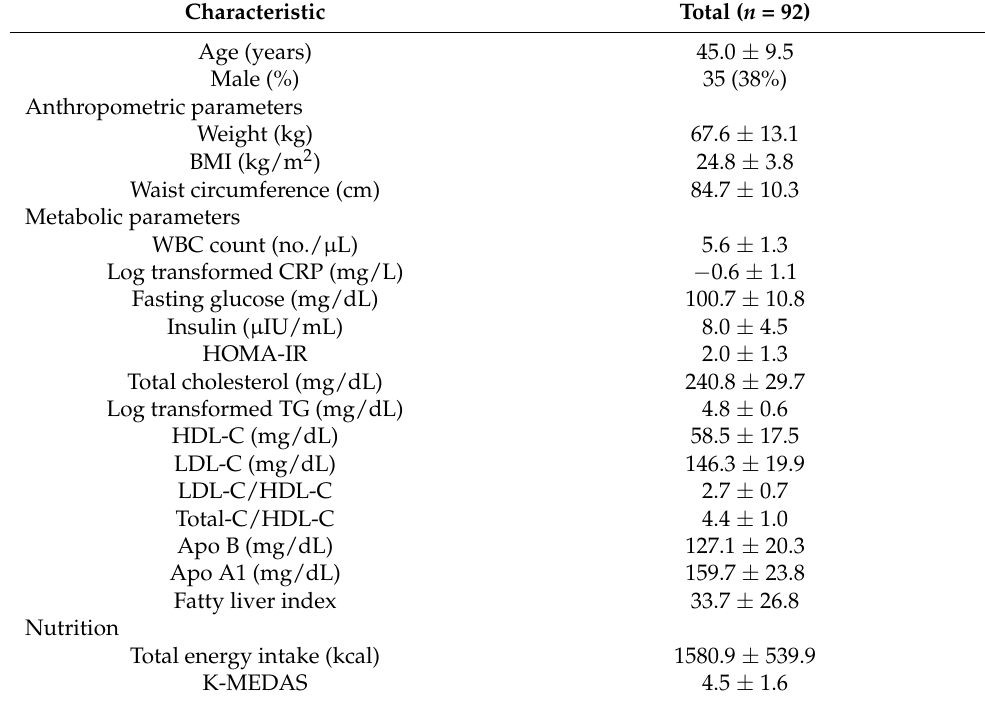
Table 1. Baseline characteristics of study participants before intervention.